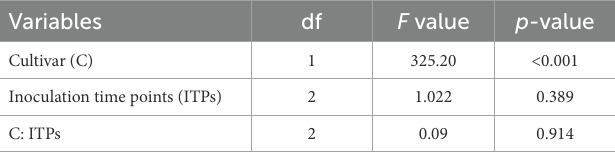
TABLE 1 ANOVA for the effect of MoT on seed infection